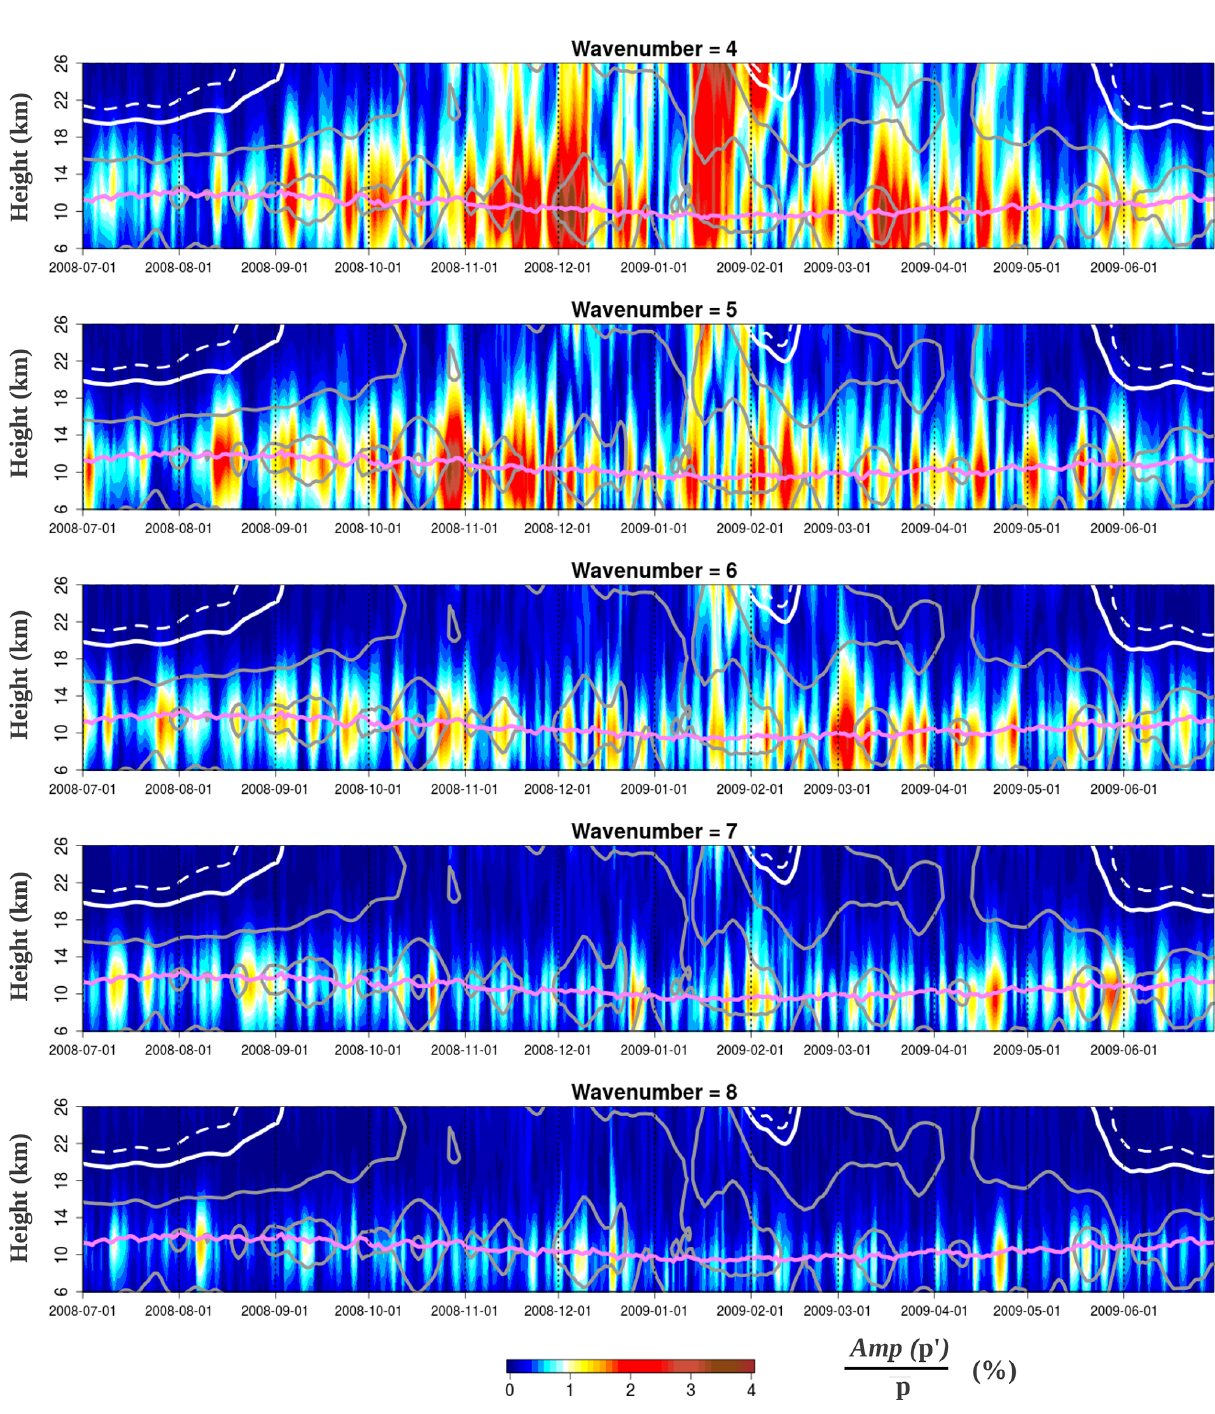
Figure 2. Same as in Fig. 1 but for wave pressure anomalies, relative to the mean pressure of each vertical